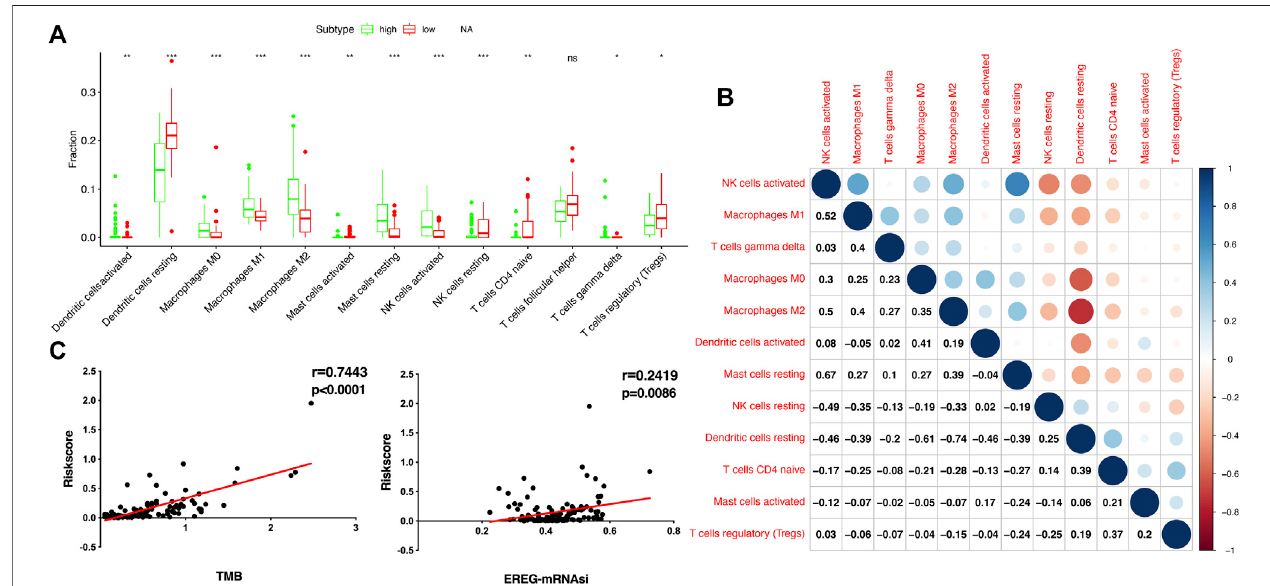
FIGURE8| Theassociationofimmunecells,TMB,andstemnesswithriskscoreinTHYM. (A) Theboxplotshowsthedifferencesin12immunecellsbetweenhigh- and low-risk score groups in THYM. (B) The correlation of those 12 immune cells in THYM. (C) The association between TMB and risk score in THYM. (D) The association between stemness index and risk score in